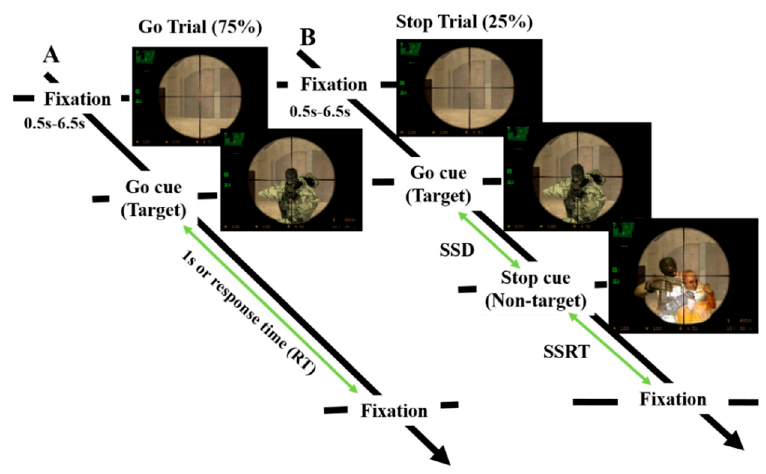
Figure 1. Experiment design of the battlefield scenario. ( A ) In the go trial, the subject was instructed to press the left button of a mouse in response to a go cue (target) stimulus as quickly as possible; ( B ) In the stop trial, a stop-signal (non-target) stimulus was used to inhibit the response. We measured each subject stop-signal delay (SSD) and stop-signal reaction time (SSRT) in the stop trials and response time (RT) in the go